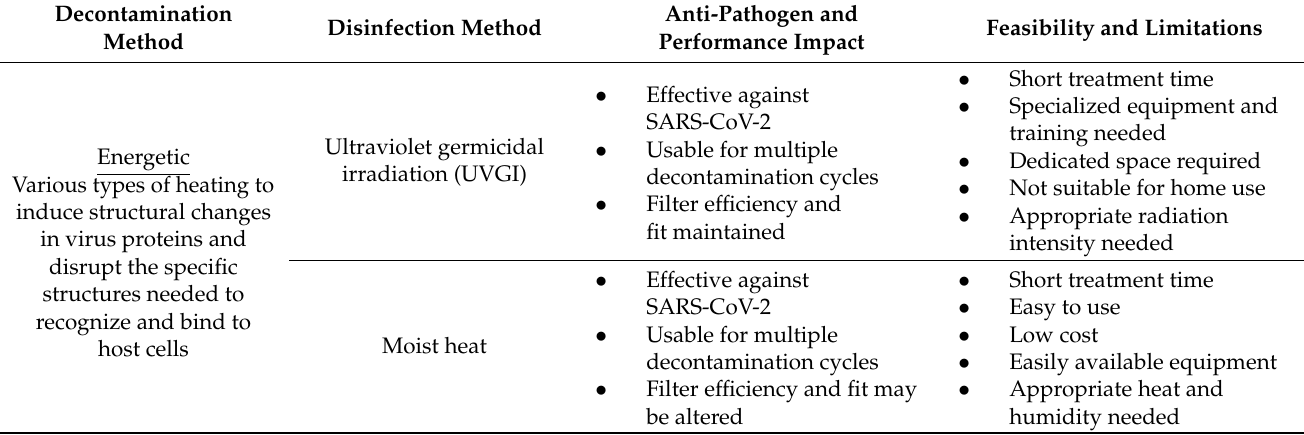
Table 6. Summaryofthemostcommonlyusedrespiratordecontaminationmethods[47,322,323,325,327,335,336,339–341,344,347,350–357].